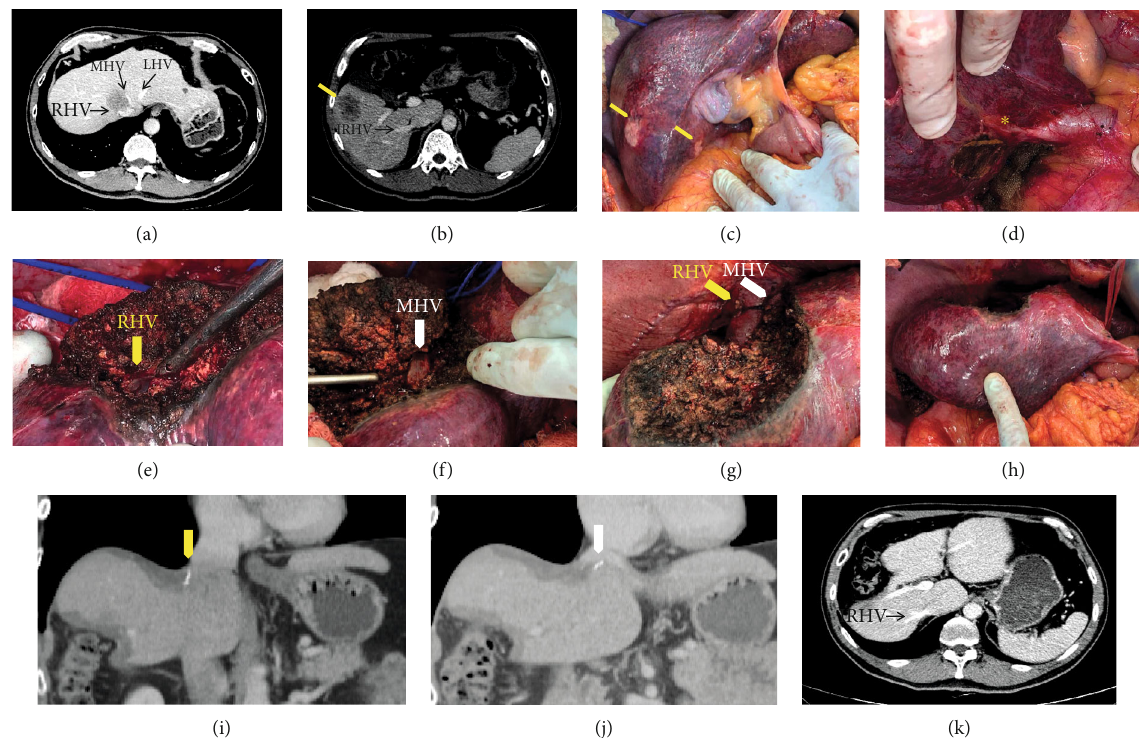
Figure 3: (Patient2) (a) Colorectal metastasis with right and middle hepatic vein invasion. (b) Inferior right hepatic vein draining the right inferior segments (S5 and S6). (c) Segment 5 liver metastasis and post FOLFOX “ blue liver aspect. ” (d) Liver mobilization and preservation of IRHV (asterisk). (e) Right hepatic vein isolation during liver transection (yellow arrow). (f) Middle hepatic vein isolation during liver transection (white arrow). (g) Immediate postoperative aspects of the liver, distal right (yellow arrow), and middle hepatic vein (white arrow) ligated at the vena cava con fl uence. (h) Right upper transversal hepatectomy and segment 5 resection. (i, j) Postoperative CT: right (yellow arrow) and middle hepatic vein (white arrow). (k) Postoperative CT: inferior right hepatic vein draining segment